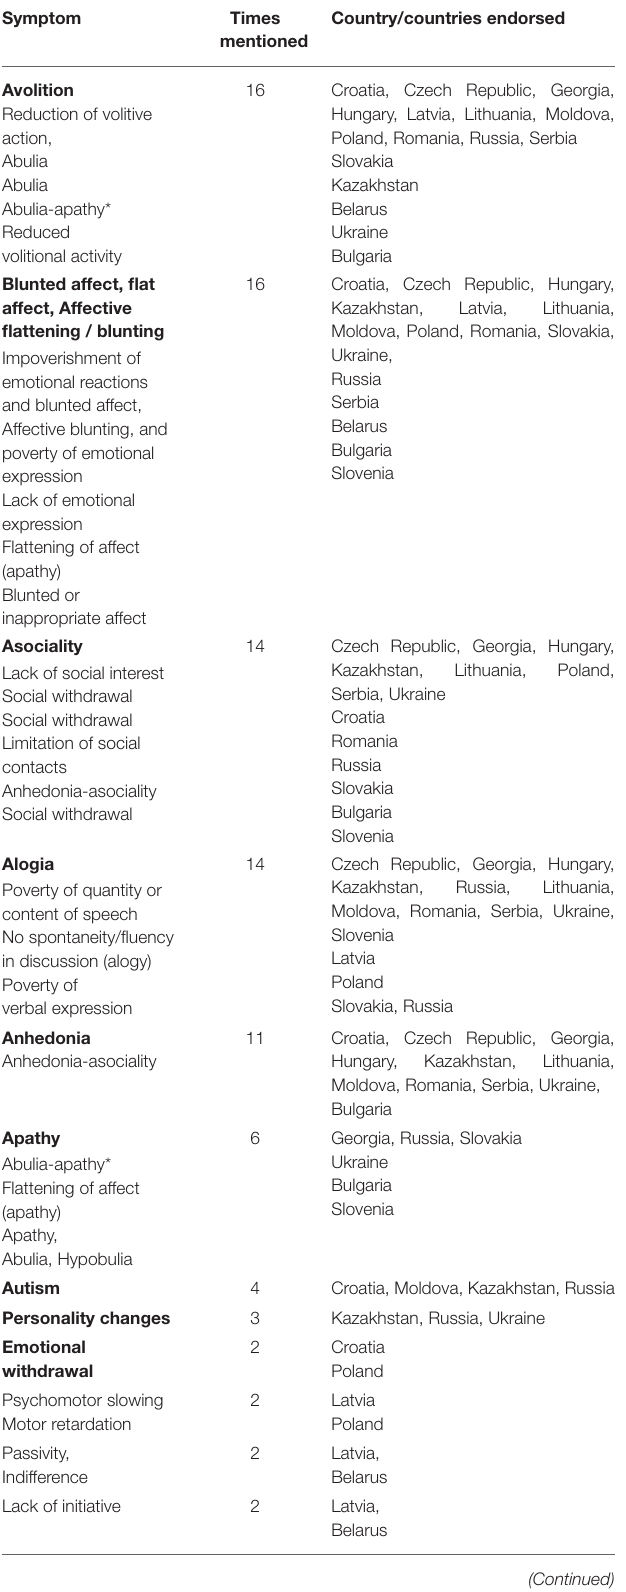
TABLE 1 | List of the negative symptoms used in 17 countries across